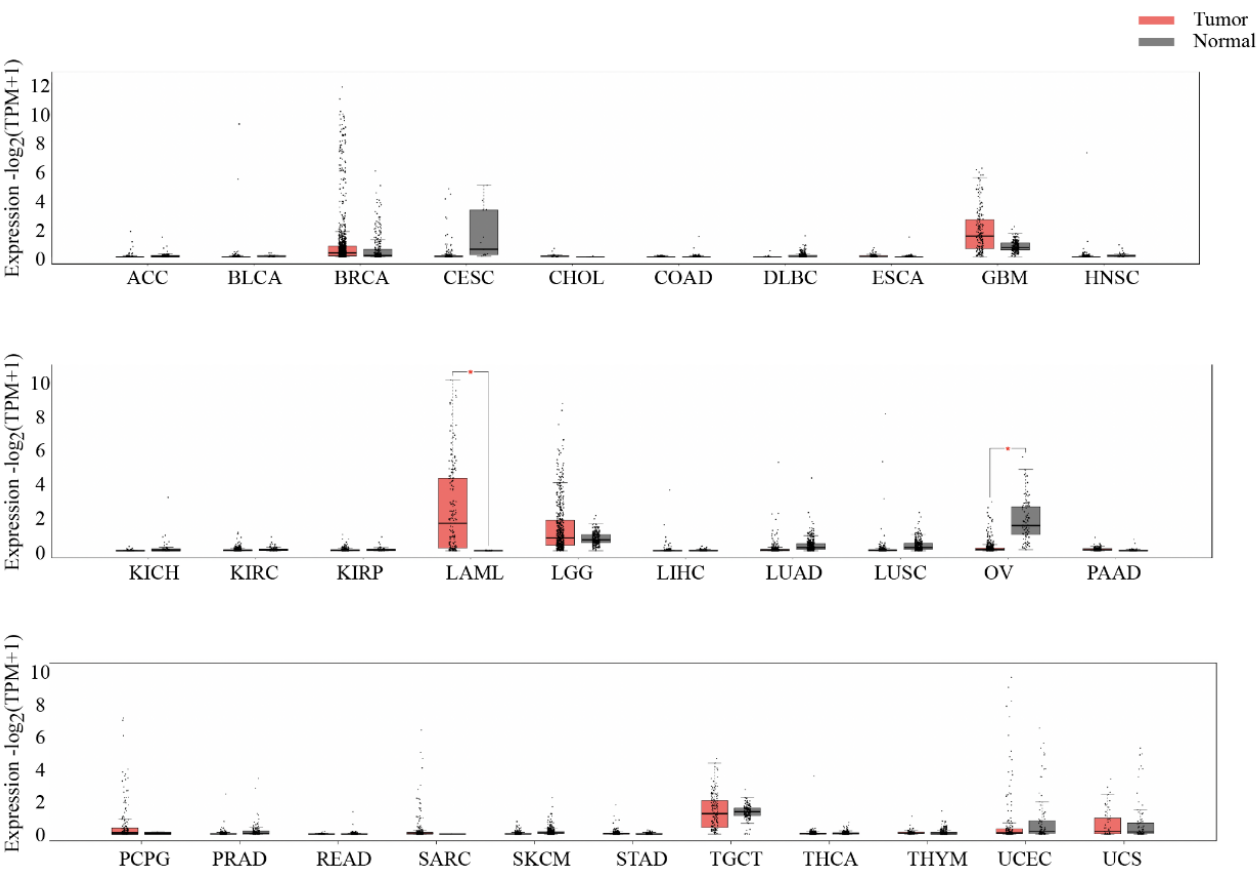
Figure 1. Expression of TRH in pan-cancer and matched normal tissues . The red bar represents tumor samples and the grey bar represents normal samples. Y axis, expression level of TRH based on the RNA-seq data. X axis, different types of cancers and matched normal data. AML refers to all subtypes in the TCGA project.